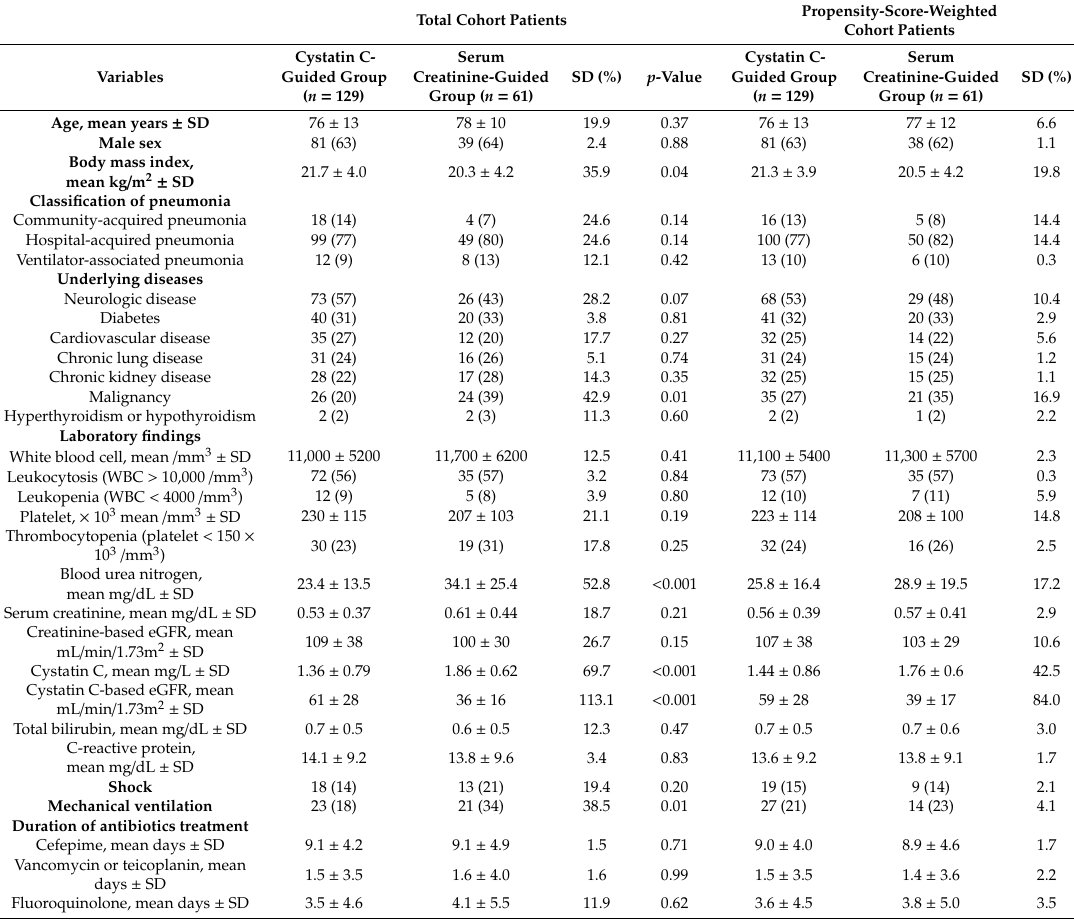
Table 1. Clinical characteristics of patients with hospitalized pneumonia who received cefepime treatment with renal dose adjustment according to cystatin C and serum